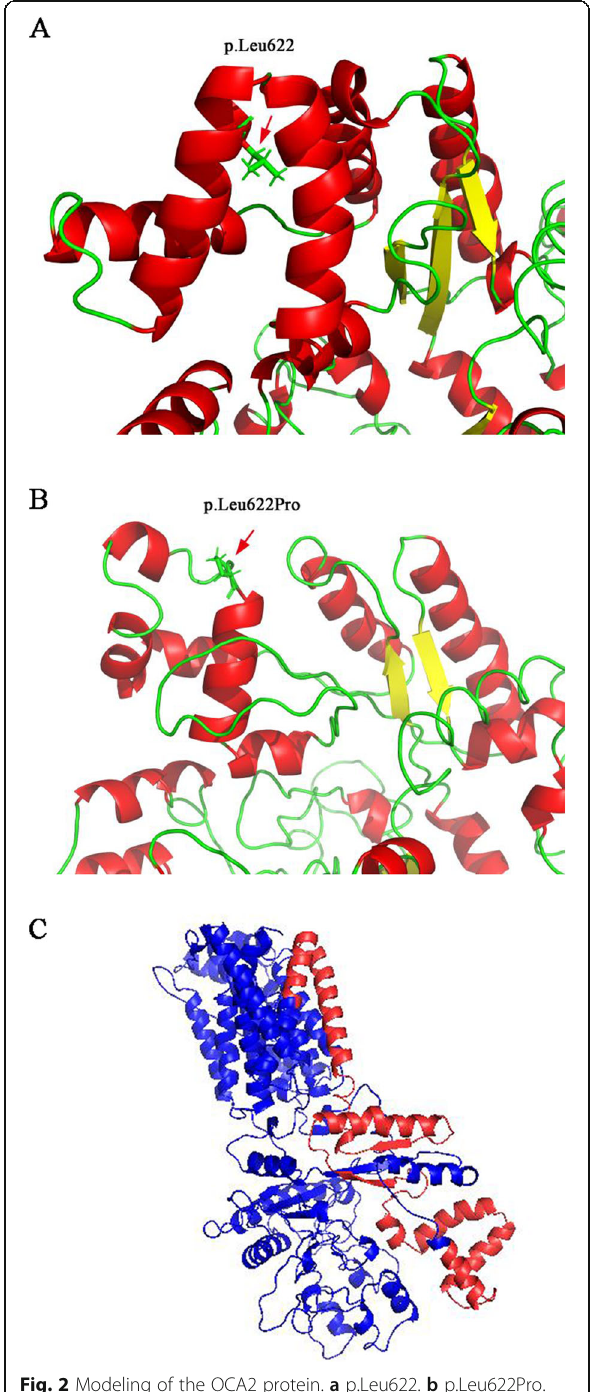
Fig. 2 Modeling of the OCA2 protein. a p.Leu622. b p.Leu622Pro. c Structural representation of exons 17 – 21 deletion. Deleted residues are indicated in red and wild type residues are presented in